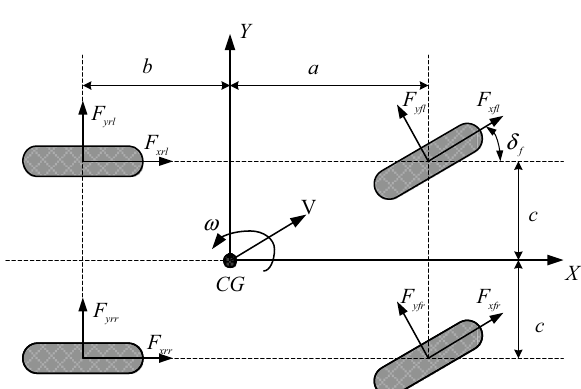
Figure 2 Schematic diagram of vehicle nonlinear